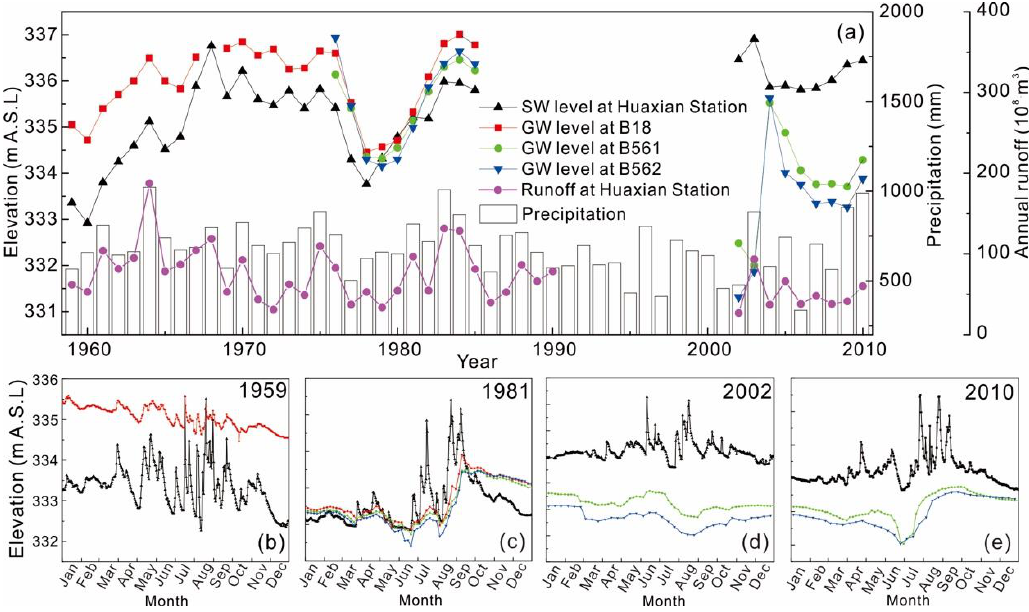
Figure 3. Comparison of surface water (SW) level, groundwater (GW) level, runoff, and precipitation: ( a ) annual average SW level at Huaxian Station, GW level at B18, B561, B562, precipitation, runoff at Huaxian Station from 1959 – 2010; ( b – e ) SW level at Huaxian Station, GW level at B18, B561, B562 in 1959, 1981, 2002, 2010.